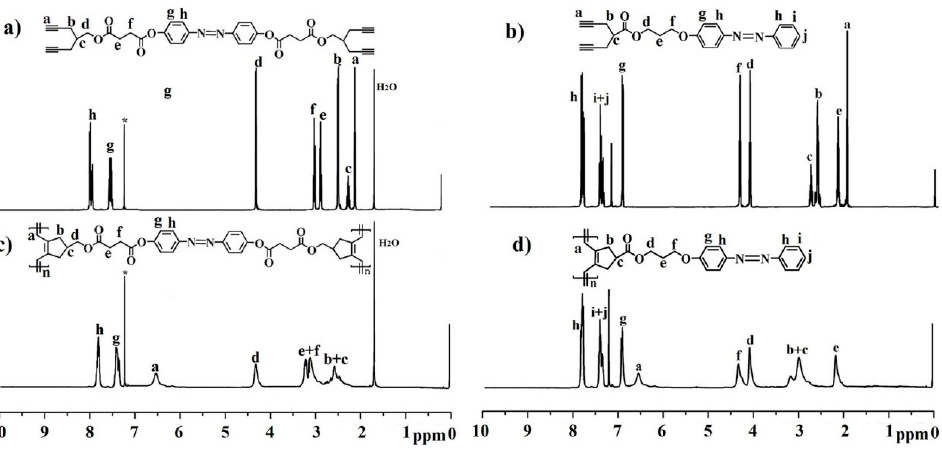
Figure 1. 1 H NMR spectra for monomer M1,M2 ( a , b ) and the corresponding polymer P1,P2 ( c , d ) in CDCl 3